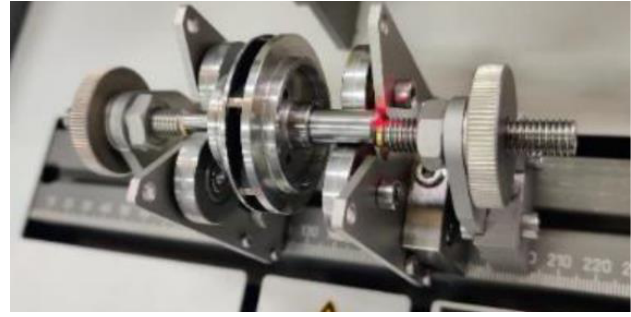
Figure 15. Closed impeller mounted on the balancing machine. Figure 16. Closed impeller mounted on the balancing